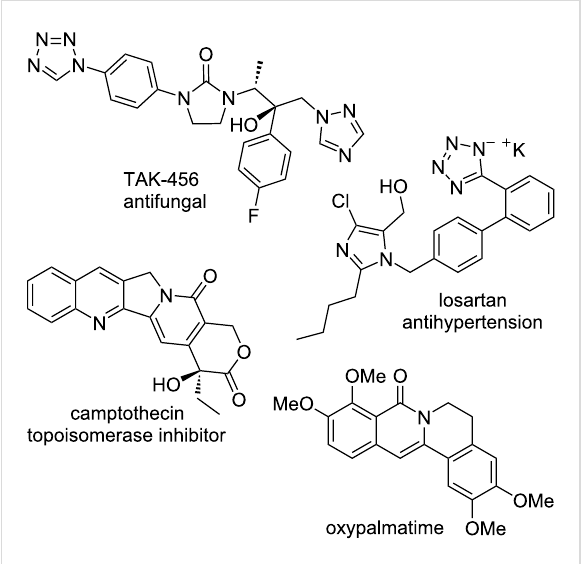
Figure 1: Bioactive molecules containing a tetrazole, pyridone or isoquinolone